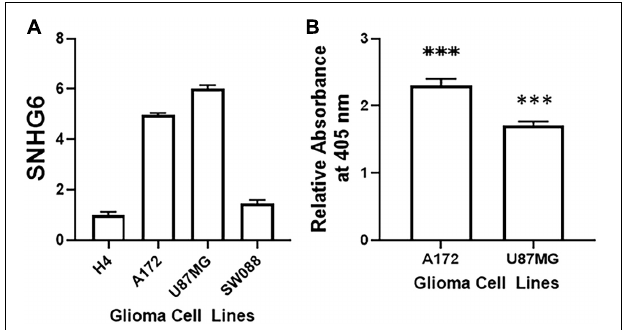
FIGURE 1 | SNHG6 levels in glioma cell lines and effect of downregulating SNHG6 on induction of apoptosis. (A) Levels of SNHG6 were evaluated in four glioma cell lines for initial screening by qRT-PCR. (B) Induction of apoptosis, upon transfection of SNHG6 siRNA in indicated cell lines, was evaluated using the apoptosis kit described in Methods. The relative OD values are plotted, which are fold-changes compared to the respective cells transfected with non-specific siRNAs. ∗∗∗ p <